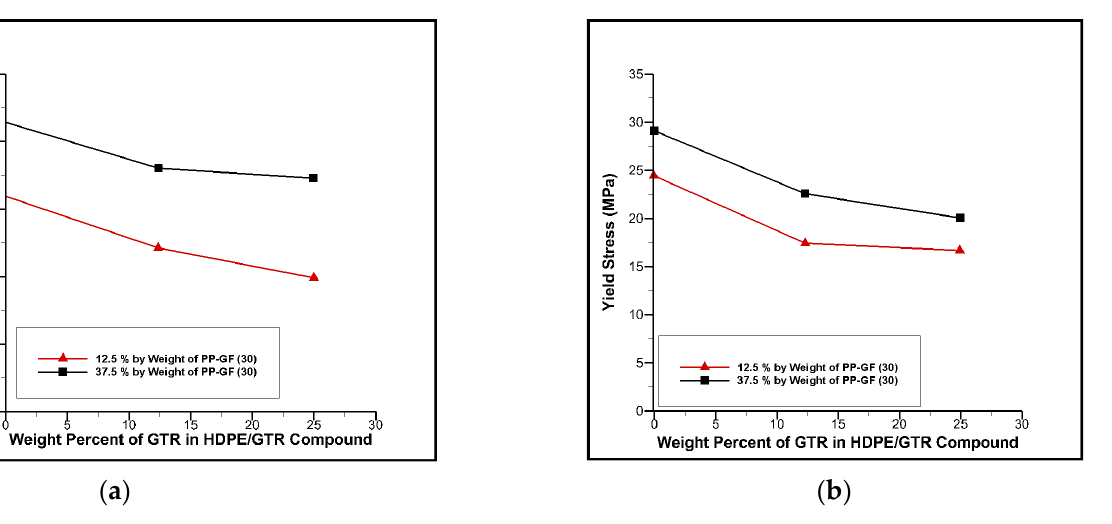
Figure 3. ( a ) Variation of the tensile modulus with the GTR content for the HDPE/GTR/PP-GF (30) composites. ( b ) Variation of the yield stress with the GTR content for the HDPE/GTR/PP-GF (30) composites [30,31].